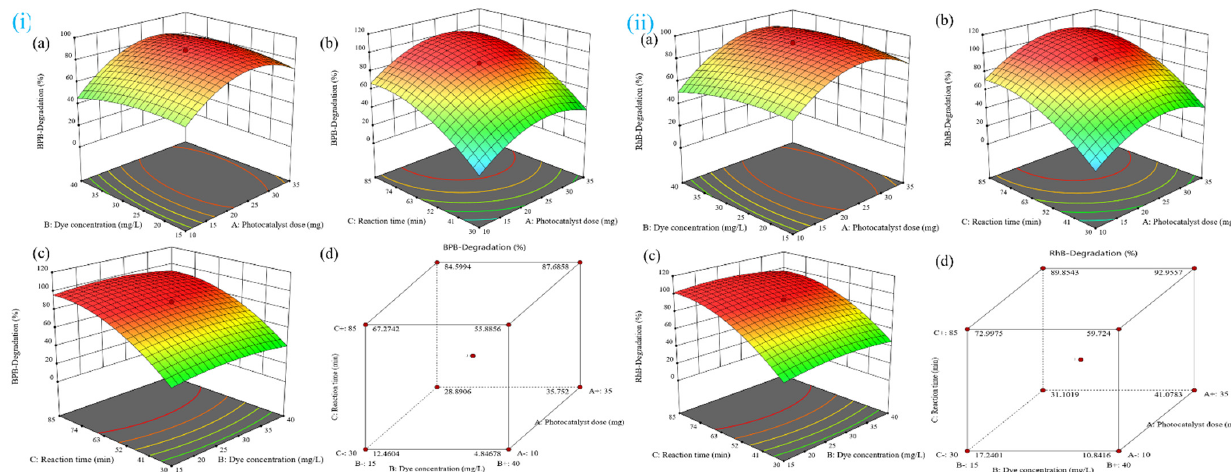
Figure 7. ( i ) 3D response surface plots for BPB of the effects of ( a ) initial dye concentration and NP dose; ( b ) contact time and NP dose; ( c ) initial dye concentration, contact time, and coded response; ( d ) cumulative effect of all variable parameters. ( ii ) 3D response surface plots for RhB of the effects of ( a ) initial dye concentration and NP dose; ( b ) contact time and NP dose; ( c ) initial dye concentration, contact time, and coded response; ( d ) cumulative effect of all variable parameters.